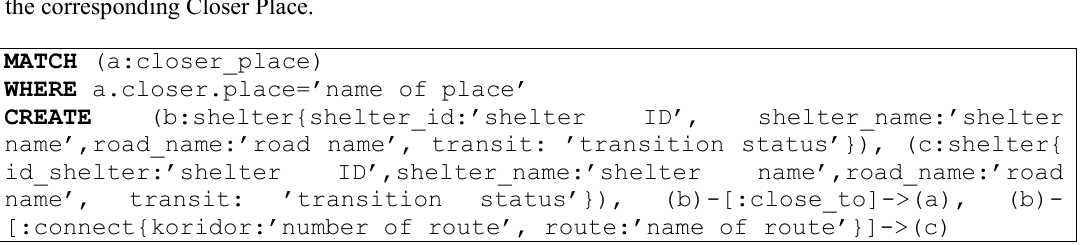
Fig. 5. Cypher query to form a relationship connected with the corridor property.